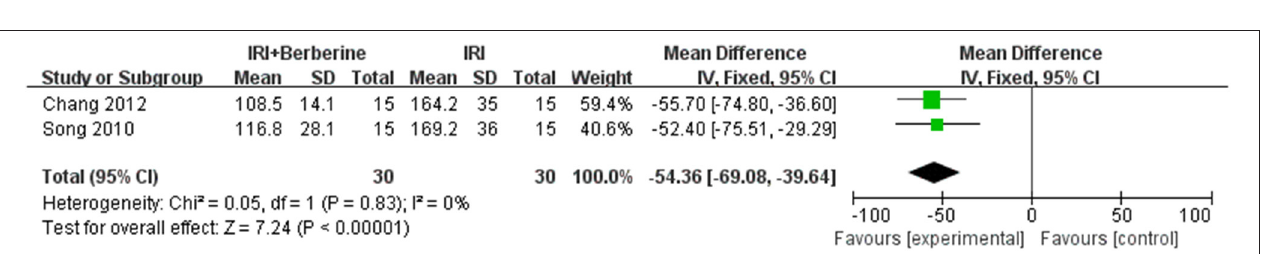
FIGURE 6 | Forest plot showing the effects of BBR on increasing LVFS compared to the control group.